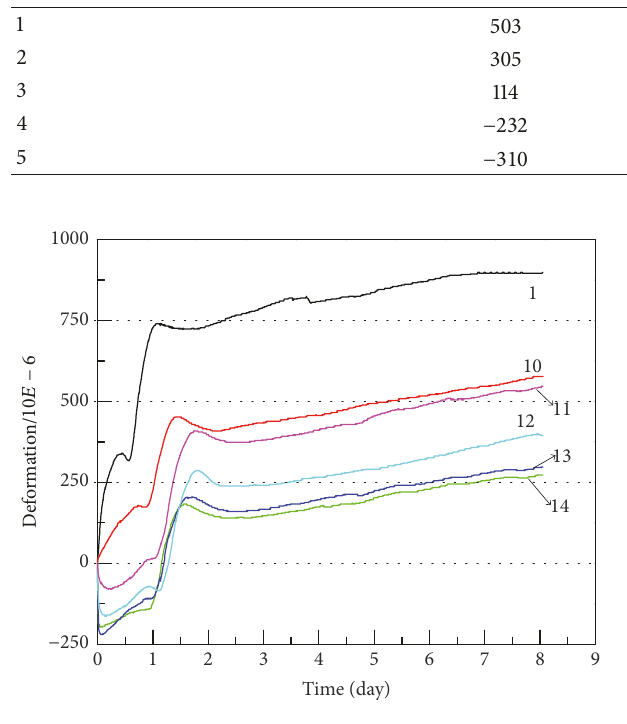
Figure 11: The autogenous shrinkage of references with